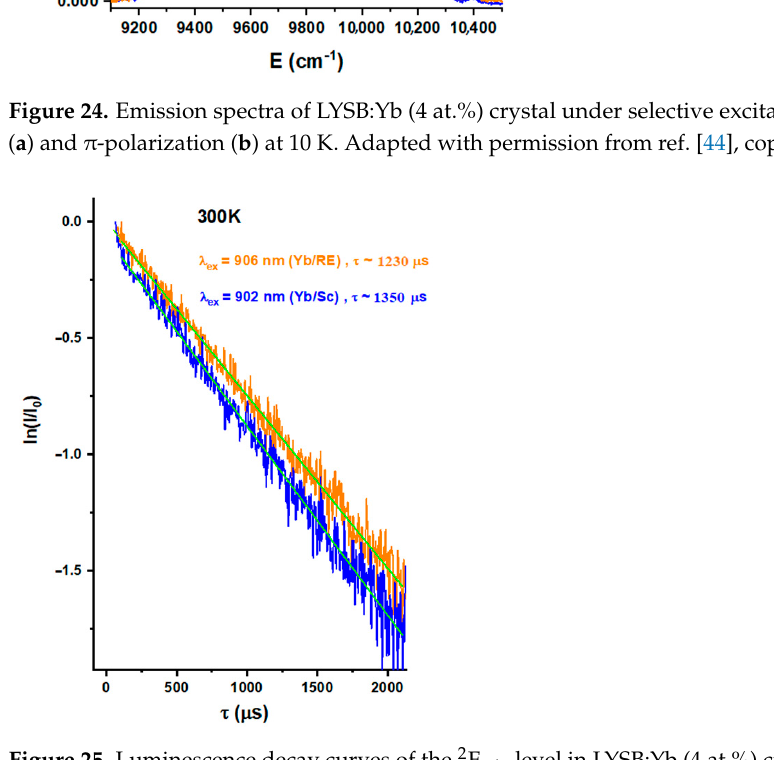
Figure 25. Luminescence decay curves of the 2 F 5/2 level in LYSB:Yb (4 at.%) crystal. Reprinted with permission from ref. [44], copyright 2020, Elsevier.